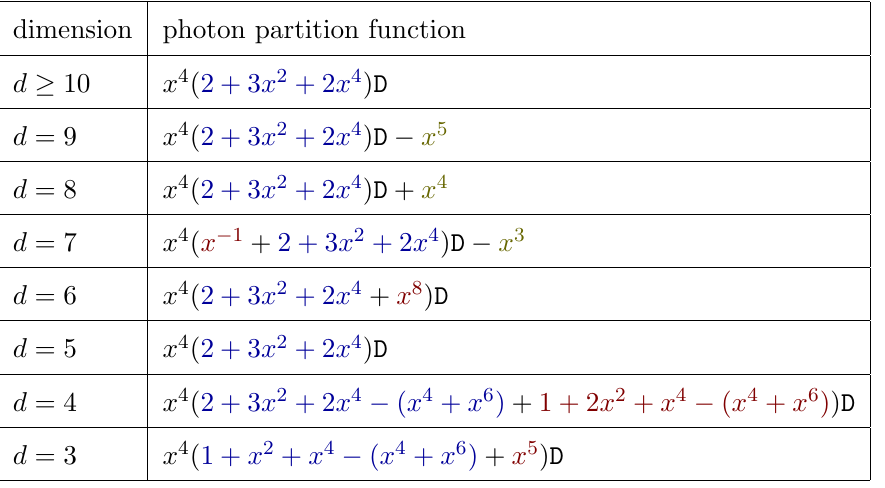
Table 6 . Partition function over the space of Lagrangians involving four F (cid:22)(cid:23) ’s. This includes both parity even and parity odd Lagrangians. Recall D (cid:17) 1 = ((1 (cid:0) x 4 )(1 (cid:0) x 6 )). Blue: Parity Even. Red: Parity Odd.